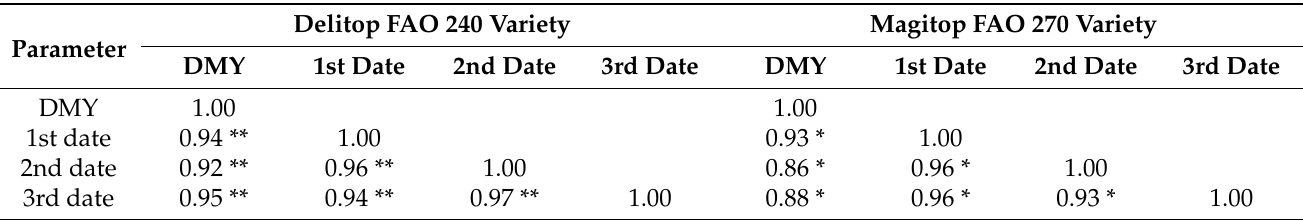
Table 5. Correlation matrix between the DMY of maize biomass and SPAD index values at successive measurement dates for Delitop and Magitop varieties (**- p < 0.01; *- p < 0.05).